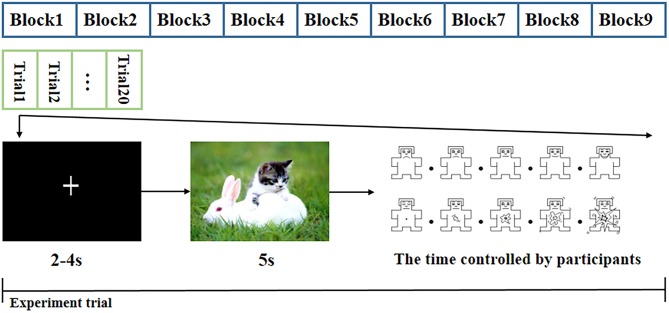
Experiment protocol.